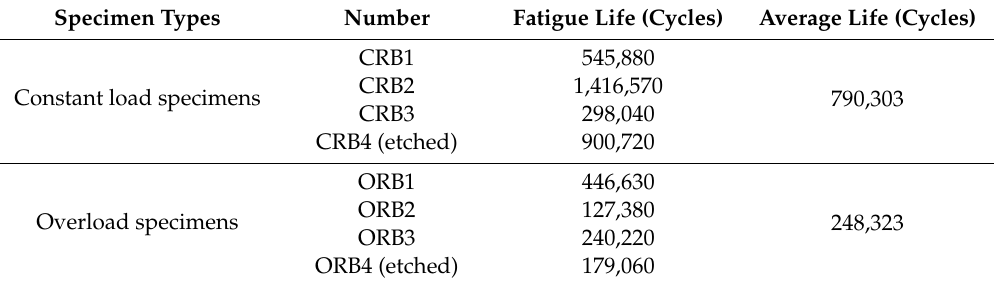
Table 1. The fatigue life of each